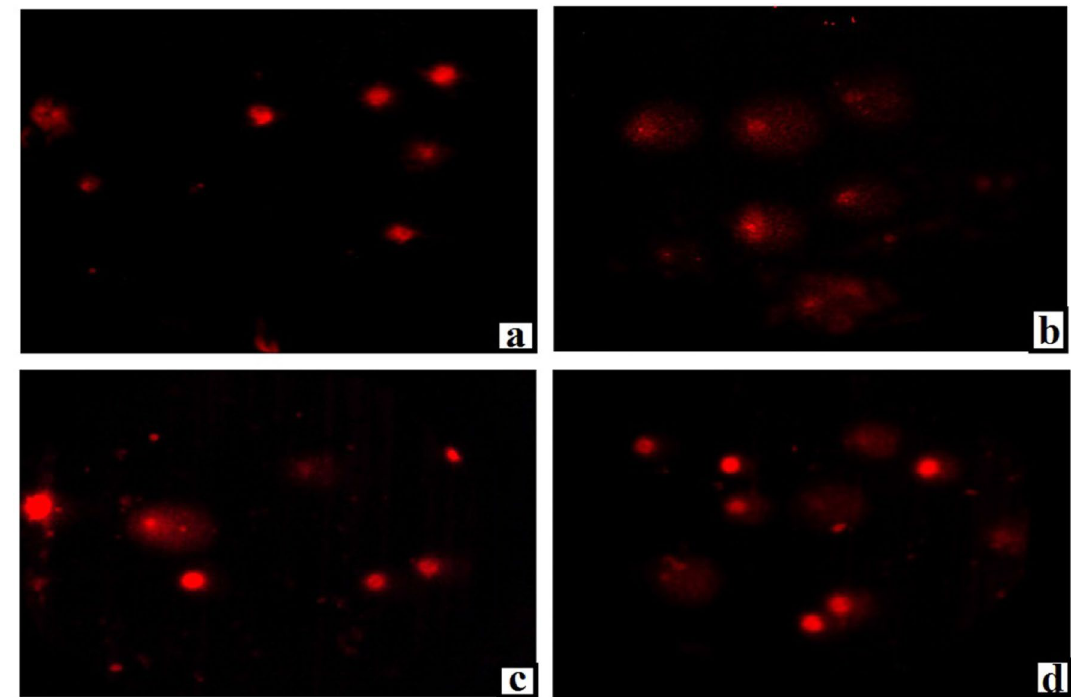
Figure 7. Representative examples for the scored Comet nuclei with intact DNA ( a ) and destructed DNA ( b – d ) with different grades of damage regardless of treatment. Magnification ×